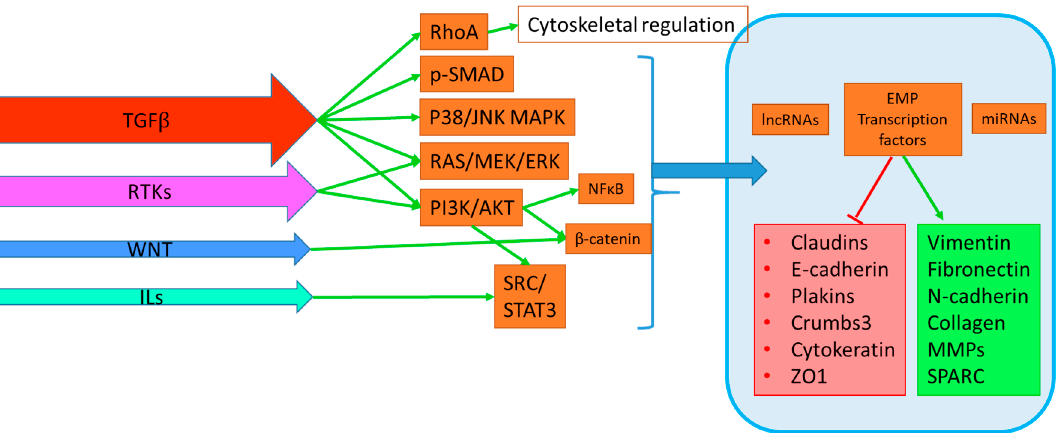
Figure 1. Simplified overview of cooperating signaling pathways in EMP.